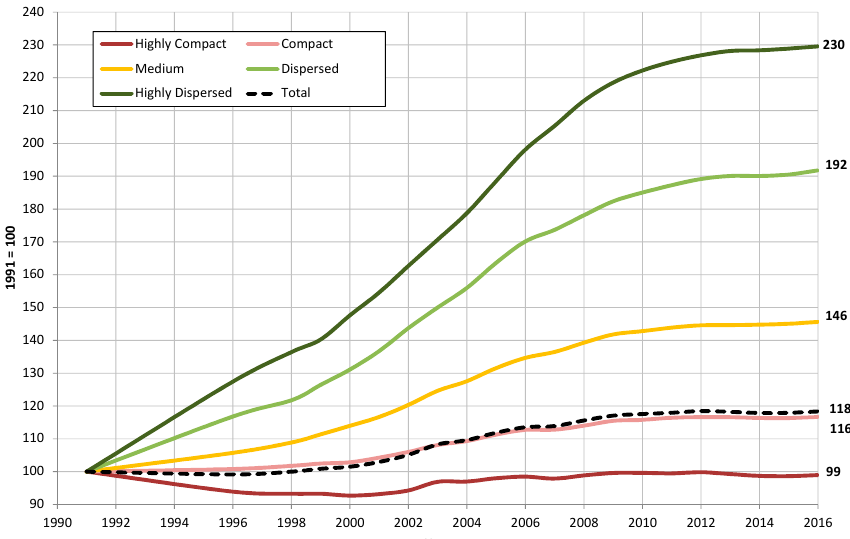
Figure 2. Population evolution in BMR municipalities classified by typology. Indexed annual data. Population in 1991 = 100. Source: Compiled by the authors based on the Censo de población (Population Census) 1991, Padrón municipal de habitantes (Municipal Register of Inhabitants) 1996, and Padrón continuo (Continuous Register) 1998–2016, by Instituto Nacional de Estadística (National Institute of Statistics) (INE).